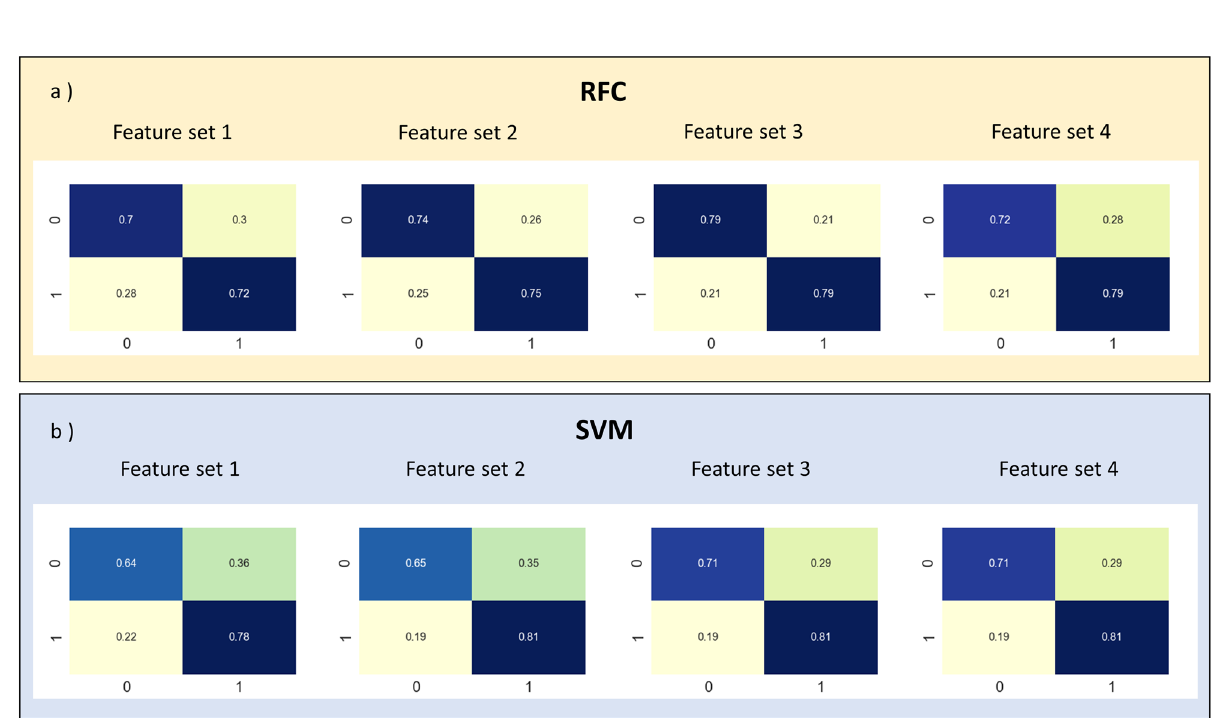
Figure 2. Binary classification confusion matrices for the considered feature sets and classification algorithms. ‘0’ stands for events classified as mainly horizontal slip motion and ‘1’ for events with relevant vertical motion component. ( a ) Normalised absolute errors for the RFC application along with 10-fold validation scheme. ( b ) Normalised absolute errors for the SVM application along with 10-fold validation